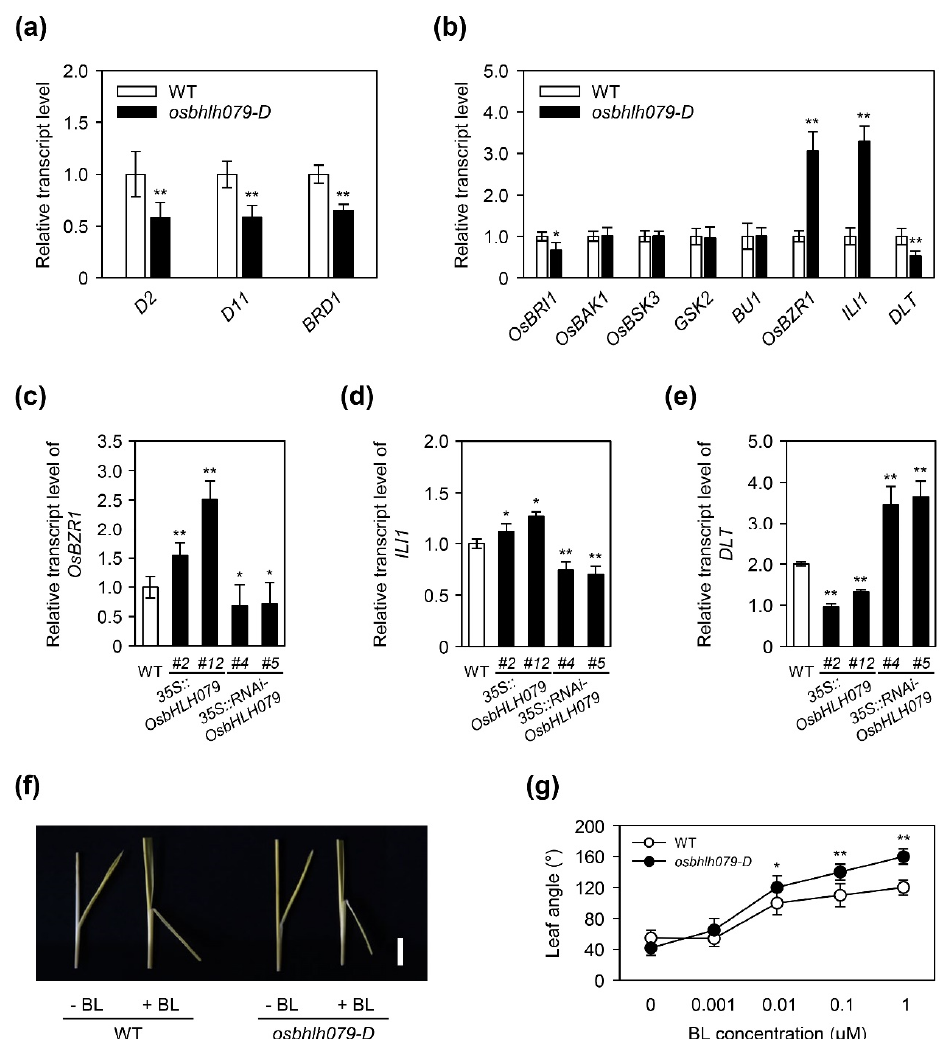
Figure 7. OsbHLH079 acts as a positive regulator of the brassinosteroid signaling pathway. ( a ) Expression patterns of brassinosteroid (BR) biosynthesis-related genes in the osbhlh079-D mutant compared to those in WT. ( b ) Altered expressions of BR signaling-related genes in the osbhlh079-D mutant compared to those in WT. ( c-e ) Altered expressions of OsBZR1 ( c ), ILI1 (D), and DLT (E) in 35S::OsbHLH079 and 35S::RNAi-OsbHLH079 compared to those in WT. ( a-e ) Total RNA was extracted from the 2-cm lamina joints between leaf blade and leaf sheath of 4-week-old plants of WT, osbhlh079-D , 35S::OsbHLH079 , and 35S::RNAi-OsbHLH079 grown under LD conditions (14.5 h light, 30°C/9.5 h dark, 24°C) with 60% relative humidity in a growth chamber. The transcript level of each gene was determined by RT-qPCR analysis and normalized to UBQ5 . Means and standard deviations were obtained from three biological replicates. Asterisks indicate statistically significant differences (* p < 0.05, ** p < 0.01, Student’s t -test) compared to WT. ( f ) BR-induced lamina joint inclination in WT and the osbhlh079-D mutant. The 2-cm lamina joint segments of 10-day-old seedlings of WT and osbhlh079-D grown at 30°C in darkness were treated with 1 μ M BL for 48 h in darkness. Scale bar = 0.5 cm. BL, 24-epibrassinolide. ( g ) Dose-dependent responses of the lamina joint of WT and osbhlh079-D to various concentrations of BL. Means and standard deviations were obtained from more than ten biological replicates. Significant differences between means were analyzed using Student’s t -test (* p < 0.05, ** p < 0.01). These experiments were repeated twice with similar results. BL, 24-epibrassinolide.